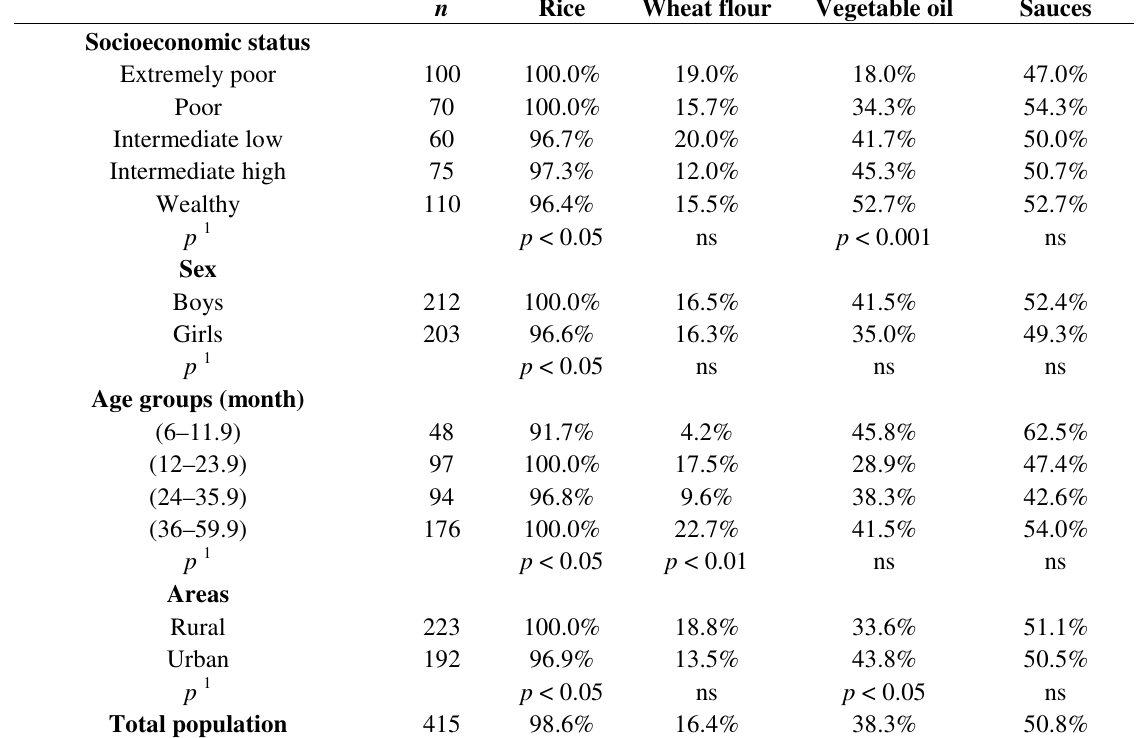
Table 3. Percentage of Vietnamese children consuming selected food, by socioeconomic status (quintile), sex, age groups and residence in the previous 24